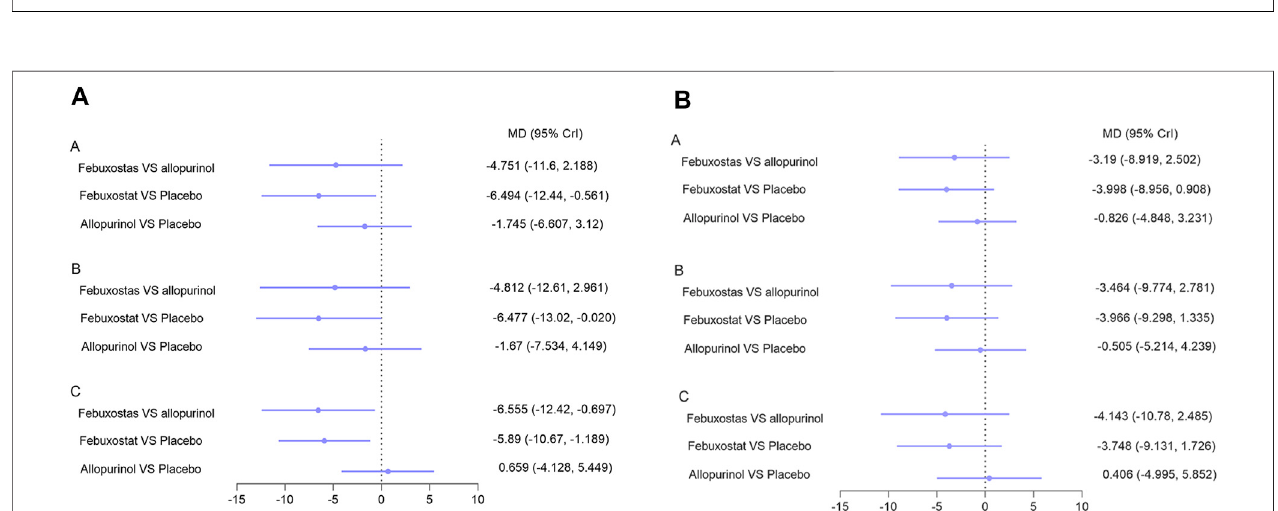
FIGURE 5 | Network meta-analysis results for lowering (A) systolic blood pressure and (B) diastolic blood pressure. Note: A : patients with CKD; B : patients with hyperuricemia and CKD; C : patients with hyperuricemia and eGFR < 60 ml/min/1.73 m 2 . Abbreviations: MD, mean difference; CrI, credible intervals; CKD, chronic kidney disease; eGFR (ml/min/1.73 m 2 ), estimated glomerular fi ltration rate.